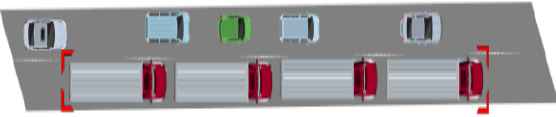
Figure 6. Platooning Example (Trucks between brackets).